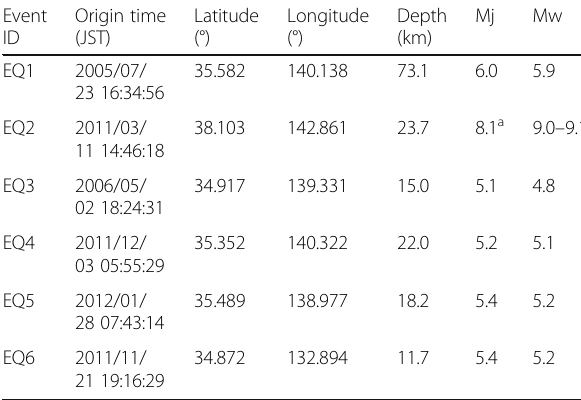
Table 3 List of events used in this